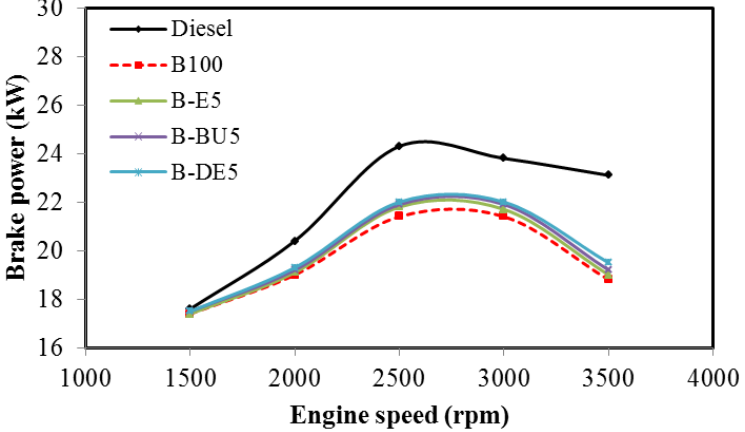
Figure 8. Engine brake power with mineral diesel fuel, palm oil methyl ester and palm oil methyl ester with different additives at 5% blending ratio (tests conducted at increasing engine speed and half open